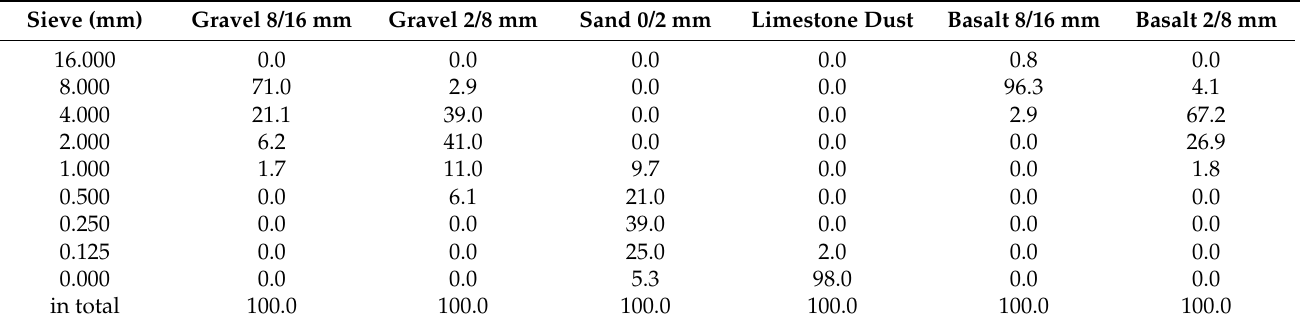
Table 10. Analysis of the grading of natural